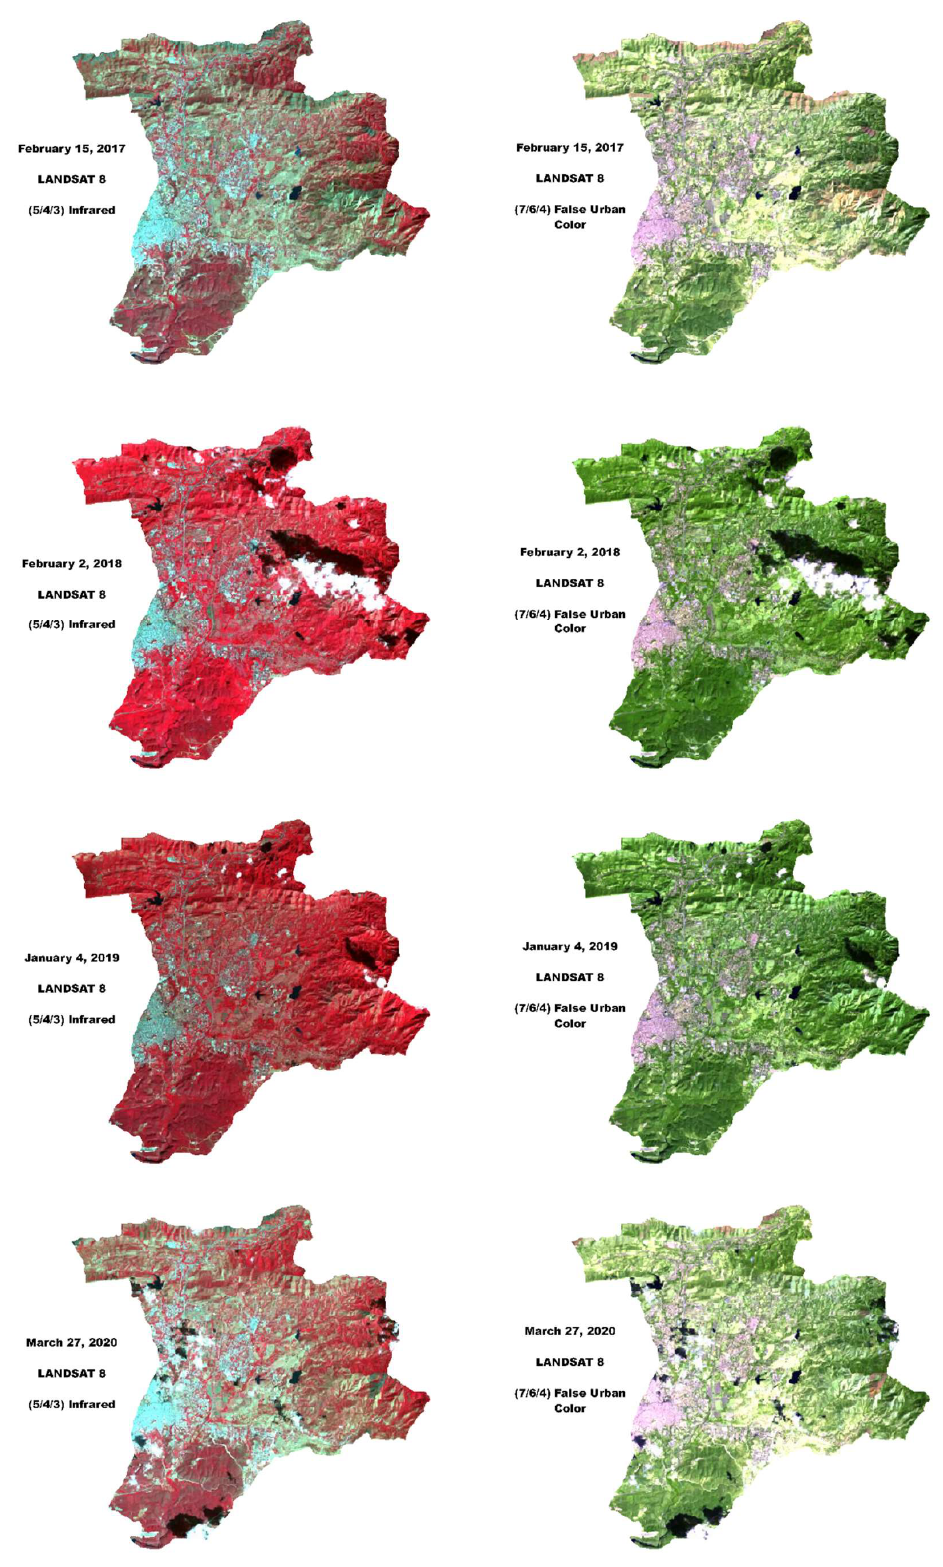
Figure A2. Satellite Band Composition Obtained.